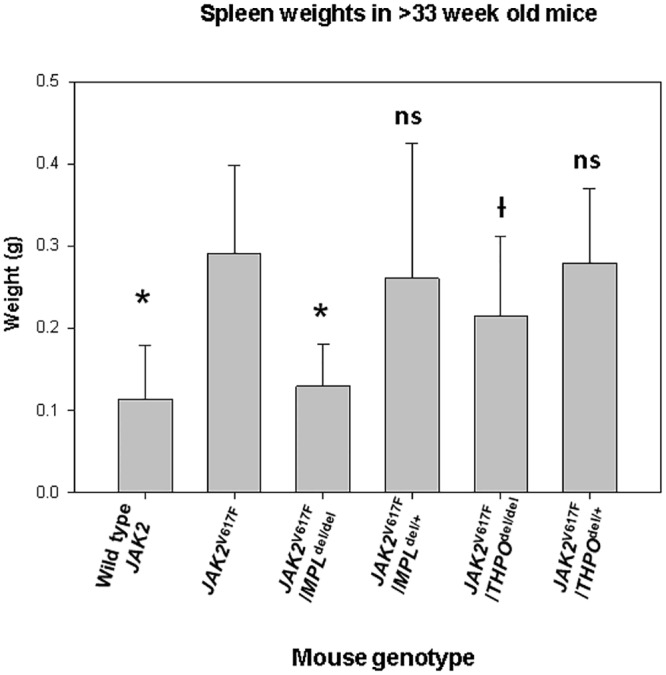
MPLdel and THPOdel/del genotypes mitigate splenomegaly in a JAK2V617F transgenic mouse model of PV while splenomegaly was restored JAK2V617F/THPOdel/+ mice.Spleen weights at > 33 weeks in wild-type mice (n = 39) and JAK2V617 (n = 53), JAK2V617F/MPLdel/del (n = 20), JAK2V617F/MPLdel/+ (n = 22), JAK2V617F/THPOdel/del (n = 20) and JAK2V617F/THPOdel/+ (n = 34) transgenic mice. The data are shown as means +/- the standard deviation. *P <0.001; ƗP <0.004; ns = not significant compared to JAK2V617F. The number (n) of mice of each genotype studied is in parentheses.